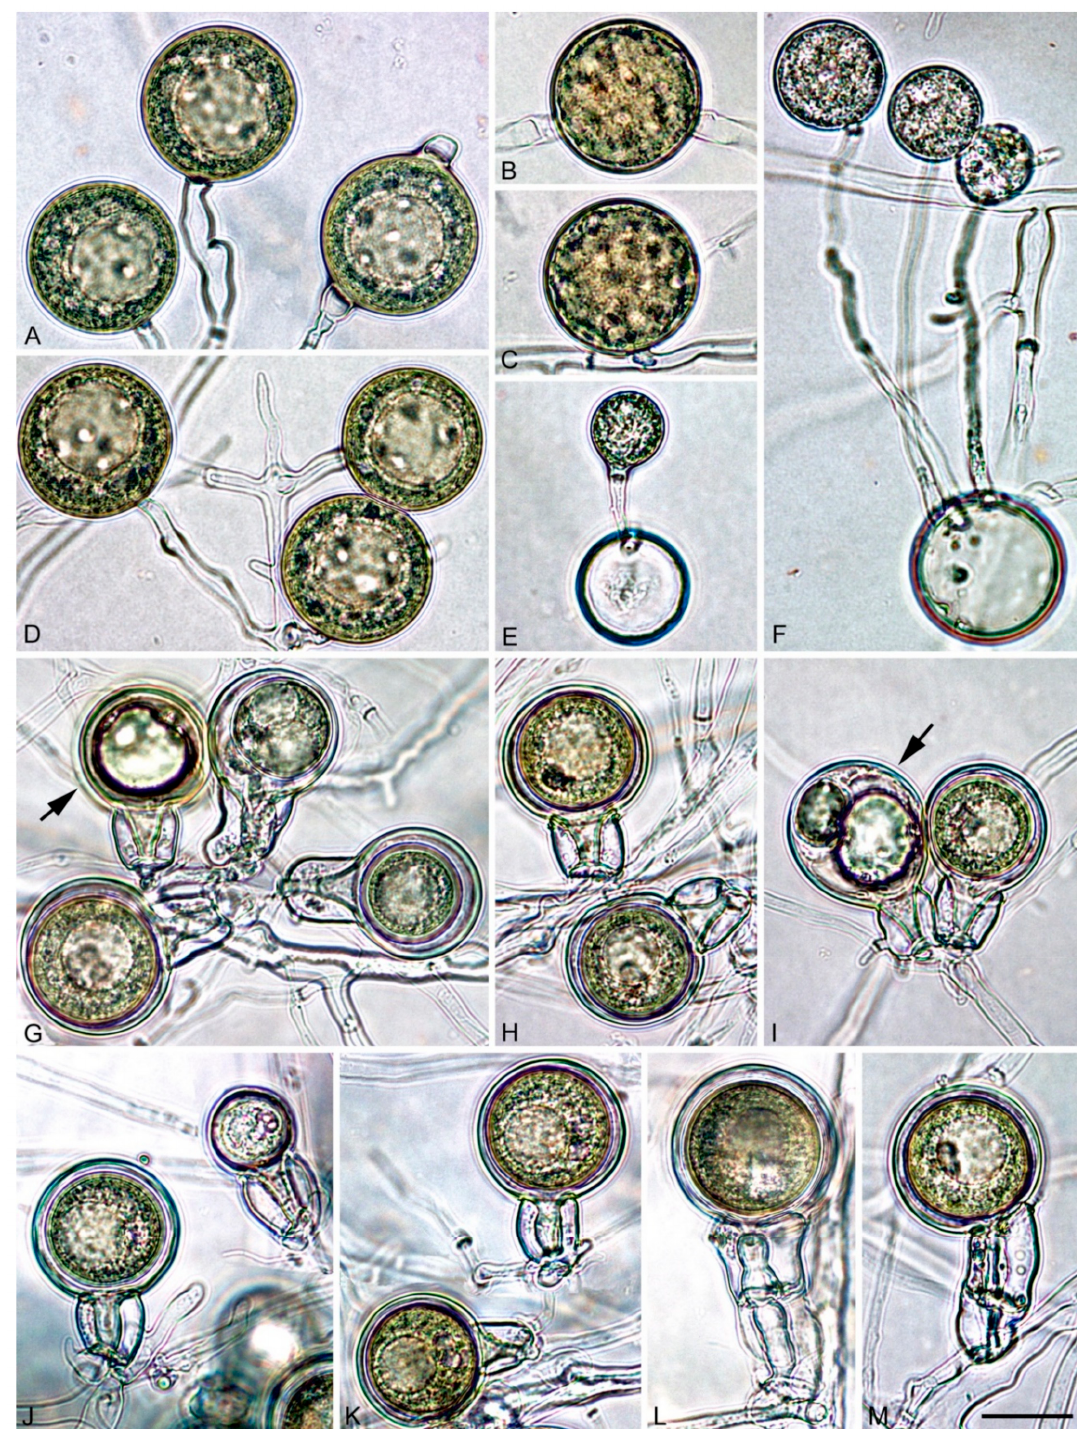
Figure 5. Chlamydospores and gametangia of Phytophthora heterospora . ( A – F ) Thick walled, globose chlamydospores; ( A , D ) terminal with lipid globules; ( B ) intercalary; ( C ) laterally attached chlamydospores; ( E , F ) germinating chlamydospores with one or more germ tubes forming new chlamydospores; ( G – M ) globose oogonia with aplerotic oospores containing large lipid globules and amphigynous antheridia; ( G ) oogonia with short tapering bases formed in a clump, one with aborted oospores (arrow); ( I ) oogonia with short tapering bases, one with aborted oospore and finger-like projection on the antheridium (arrow); ( J , K ) oogonia with short unicellular antheridia; ( L ) oogonia with very long bicellular antheridium; ( M ) comma-shaped oogonium with long bicellular antheridium. Scale bar: 25 µ